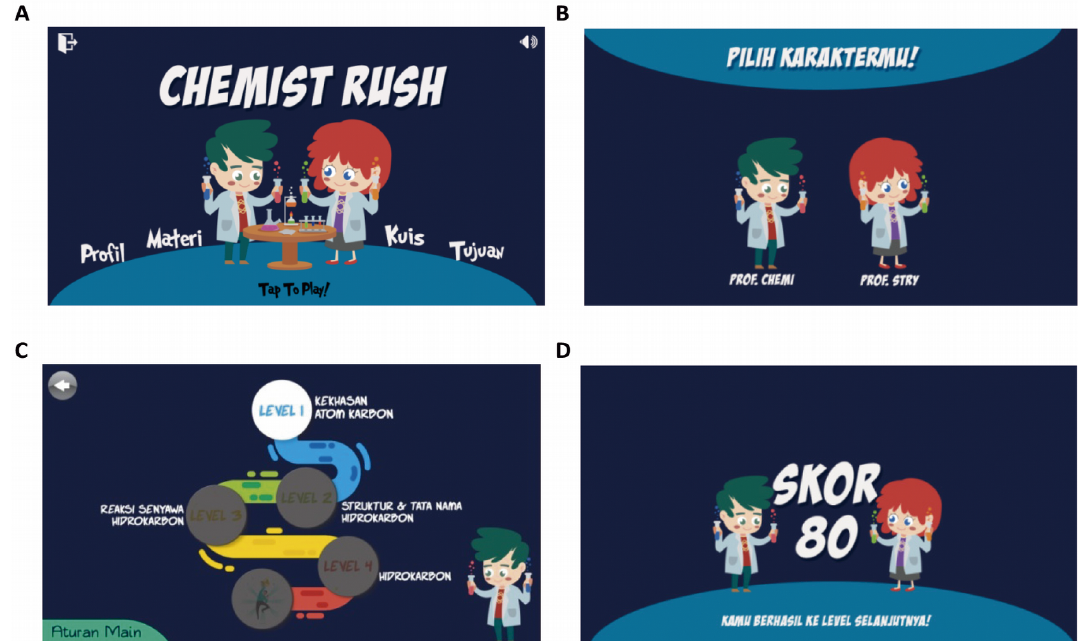
Figure 2. The Hydrocarbons Chem-Rush game design. A. Game